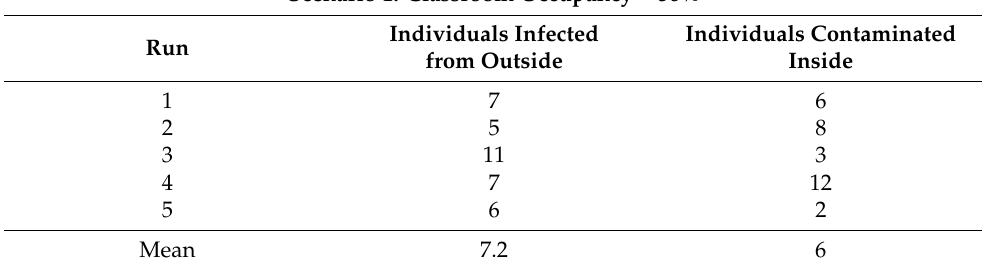
Table 9. Scenario 1